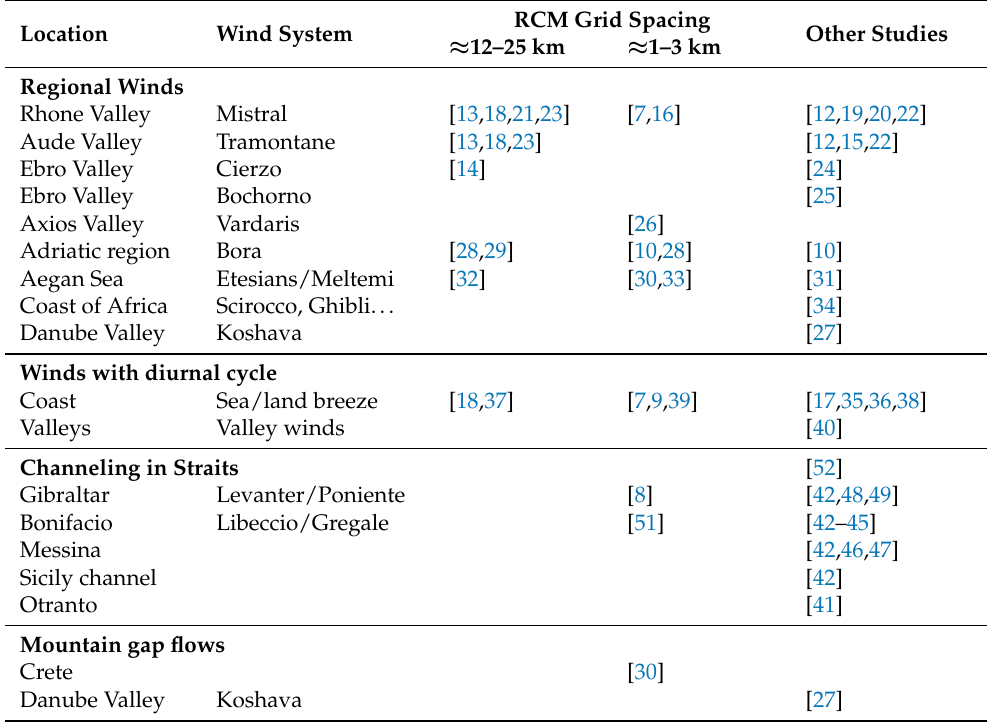
Table 2. Studies included in this review. The column ‘Other Studies’ includes idealized and ocean only studies, as well as reviews and process